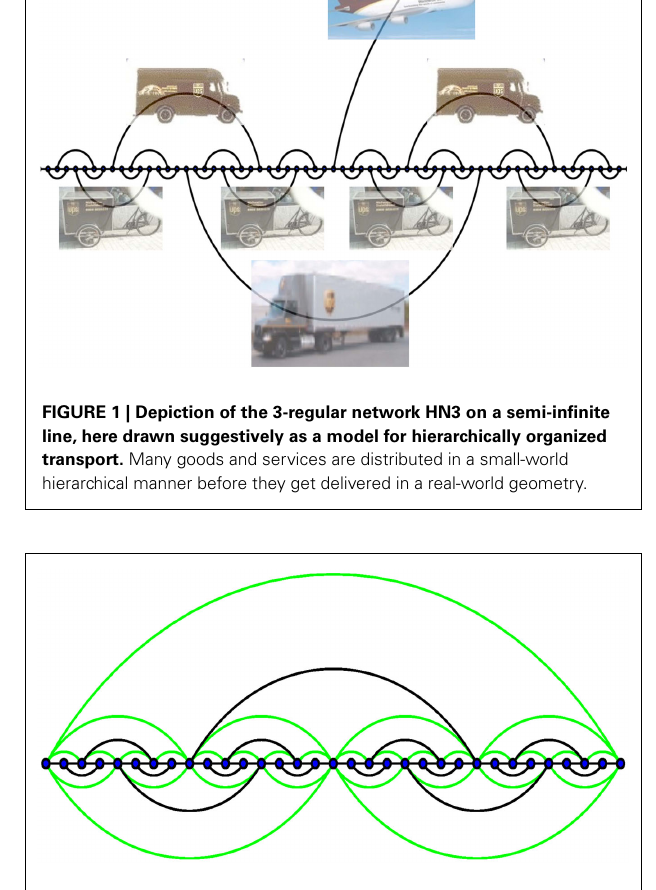
FIGURE 2 | Depiction of the planar network HN5, comprised of HN3 (black lines) with the addition of further long-range bonds (green-shaded lines). Note that sites on the lowest level of the hierarchy have degree 3, then degree 5, 7, etc., comprising a fraction of 1/2, 1/4, 1/8, etc., of all sites, which makes for an average degree 5 in this